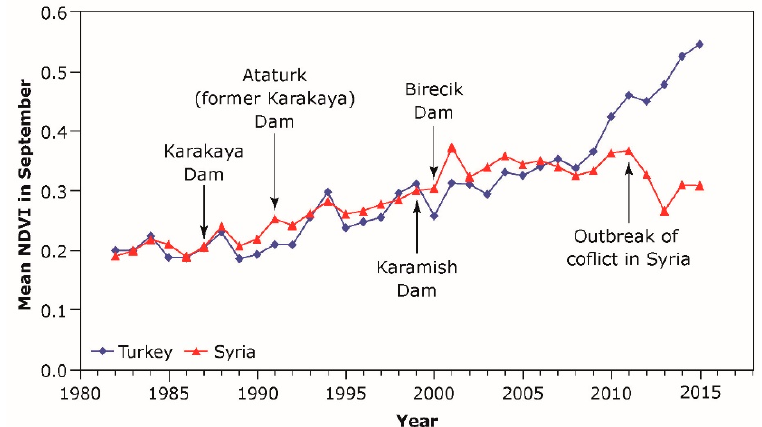
Figure 4. Long-term time series of the mean Normalized Difference Vegetation Index (NDVI) in September. Values gradually increased in both Turkey and Syria until 2008, reflecting steady agricultural growth in both countries. Later, NDVI values dramatically increased in Turkey and sharply decreased in Syria. Values were extracted from a combined dataset of NOAA-AVHRR and MODIS spaceborne systems.